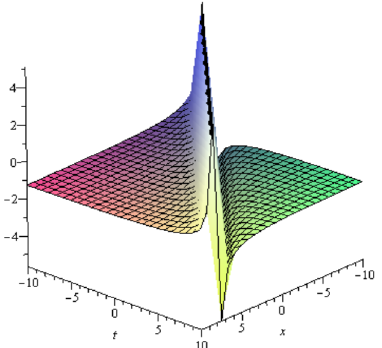
Figure 5. The solitary wave 3D graphics of Equation (26) provides a singular kink soliton profile for, A 0 “ 1, m “ 1, ω “ ´ 1, k 1 “ 1, k “ 2, l “ 2, A “ 2, B “ 3, µ “ 0, λ “ 2, E “ 1 within the interval ´ 10 ď x , t ď 10.